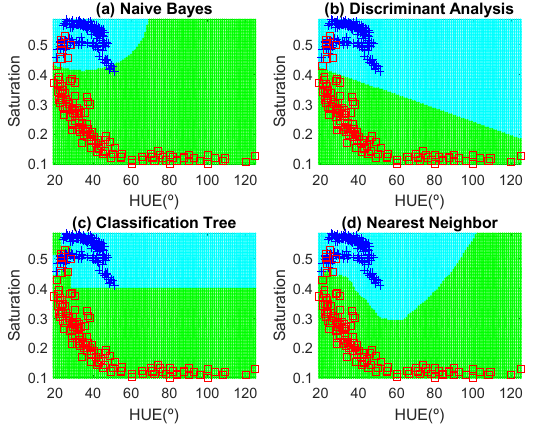
Figure 16. Decision boundaries and scatter plot (class 1 squares, class 2, crosses) for the banana. ( a ) Naive Bayes, ( b ) linear discriminant analysis, ( c ) classification tree and ( d ) Nearest Neighbor (k=5).